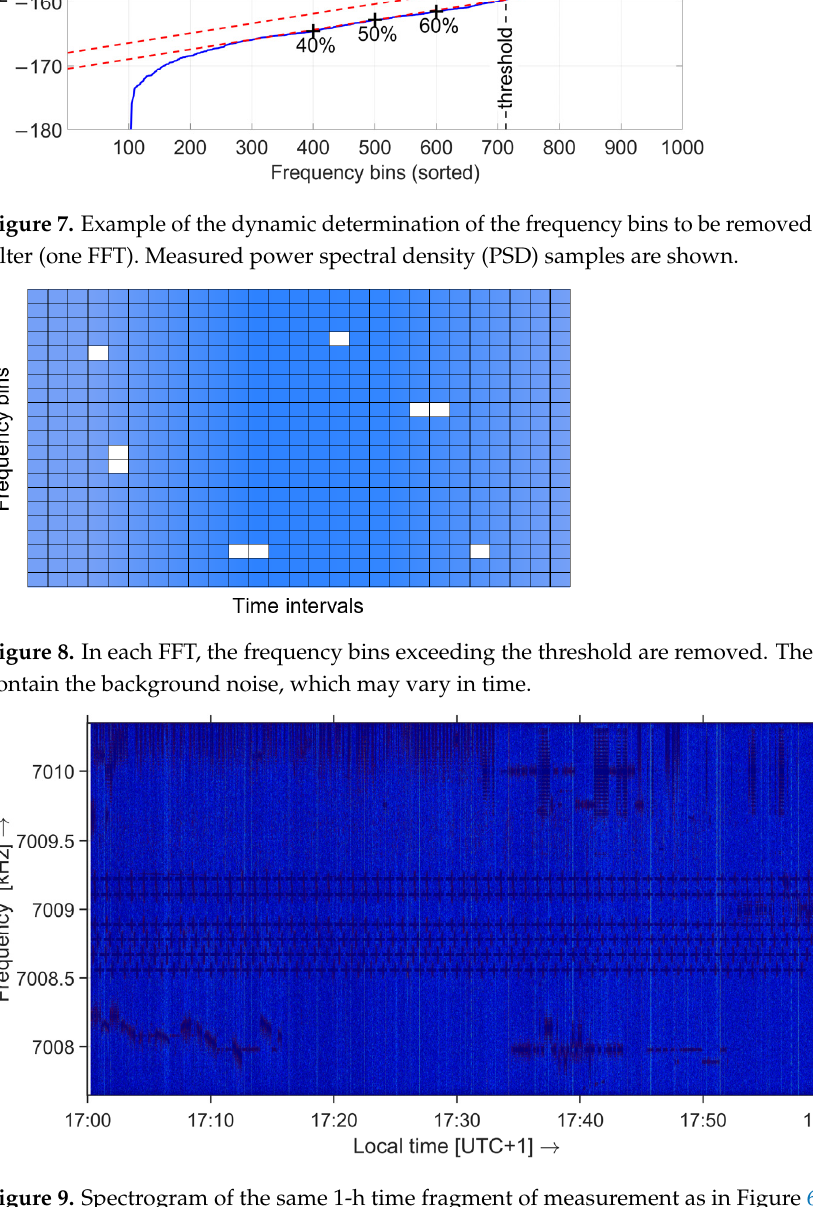
Figure 9. Spectrogram of the same 1-h time fragment of measurement as in Figure 6, after adaptive filtering. The beacon and other radio signals are removed, while the background ambient noise and superimposed impulsive noise remain.